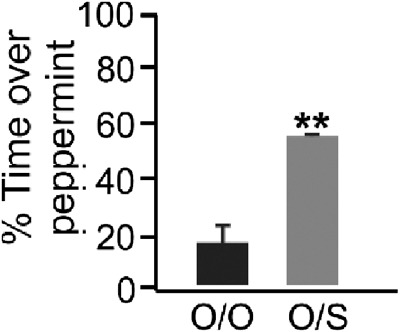
Preference for peppermint after 10 min training session. Black bar represents pups exposed to peppermint odor only during training. Gray hatched bar represents pups given intermittent stroking while exposed to peppermint odor. Unpaired t(4) = 4.60, **P < 0.005. Error bars represent standard errors of the mean (SEMs).